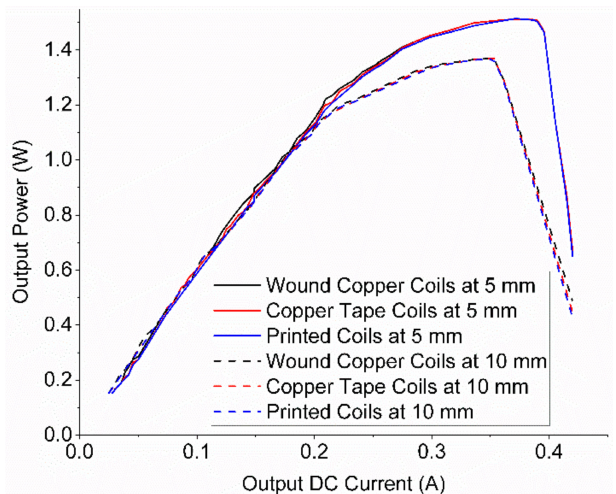
Figure 10. Output powers of wireless power transfer system deployed with different type of coupled coils against output DC current at 5 mm and 10 mm separation between transmitter and receiver coils. An approximate 1.51 W output power can be achieved for all types of coils at 5 mm separation, and 9% less output power, 1.37 W, can be achieved at 10 mm